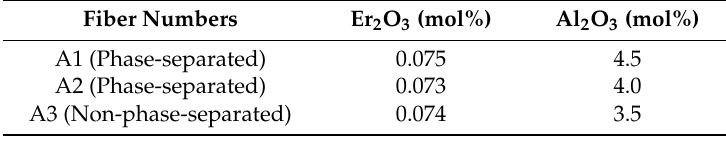
Figure 2. Modified chemical vapor deposition (MCVD) of porous silica layer within the silica tube and along the forward direction. Table 1. The composition of three Er 2 O 3 -doped fiber preforms (Measured by electron probe microanalysis).